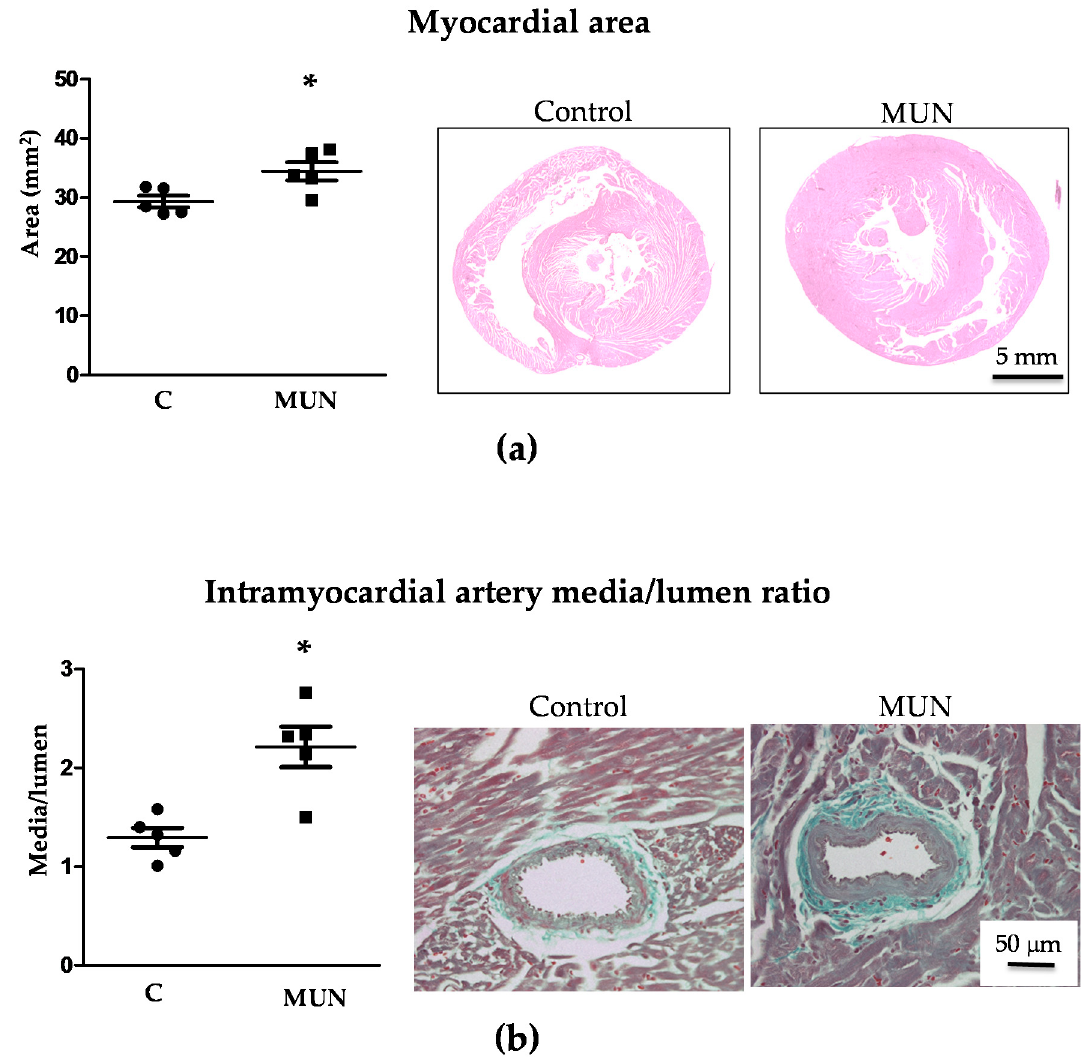
Figure 2. Myocardial and intramyocardial artery area in 21-day old male offspring from rats exposed to maternal undernutrition during pregnancy (MUN) and control rats fed ad libitum (C). ( a ) Myocardial area with representative images from sections stained with hematoxylin-eosin and captured with × 10 objective; ( b ) intramyocardial artery media/lumen and representative images stained with Masson Trichrome Stain and captured with a × 40 objective. Sample size per group: 7 rats from 5 litters. Student’s t test, * p < 0.05 compared to C rats.